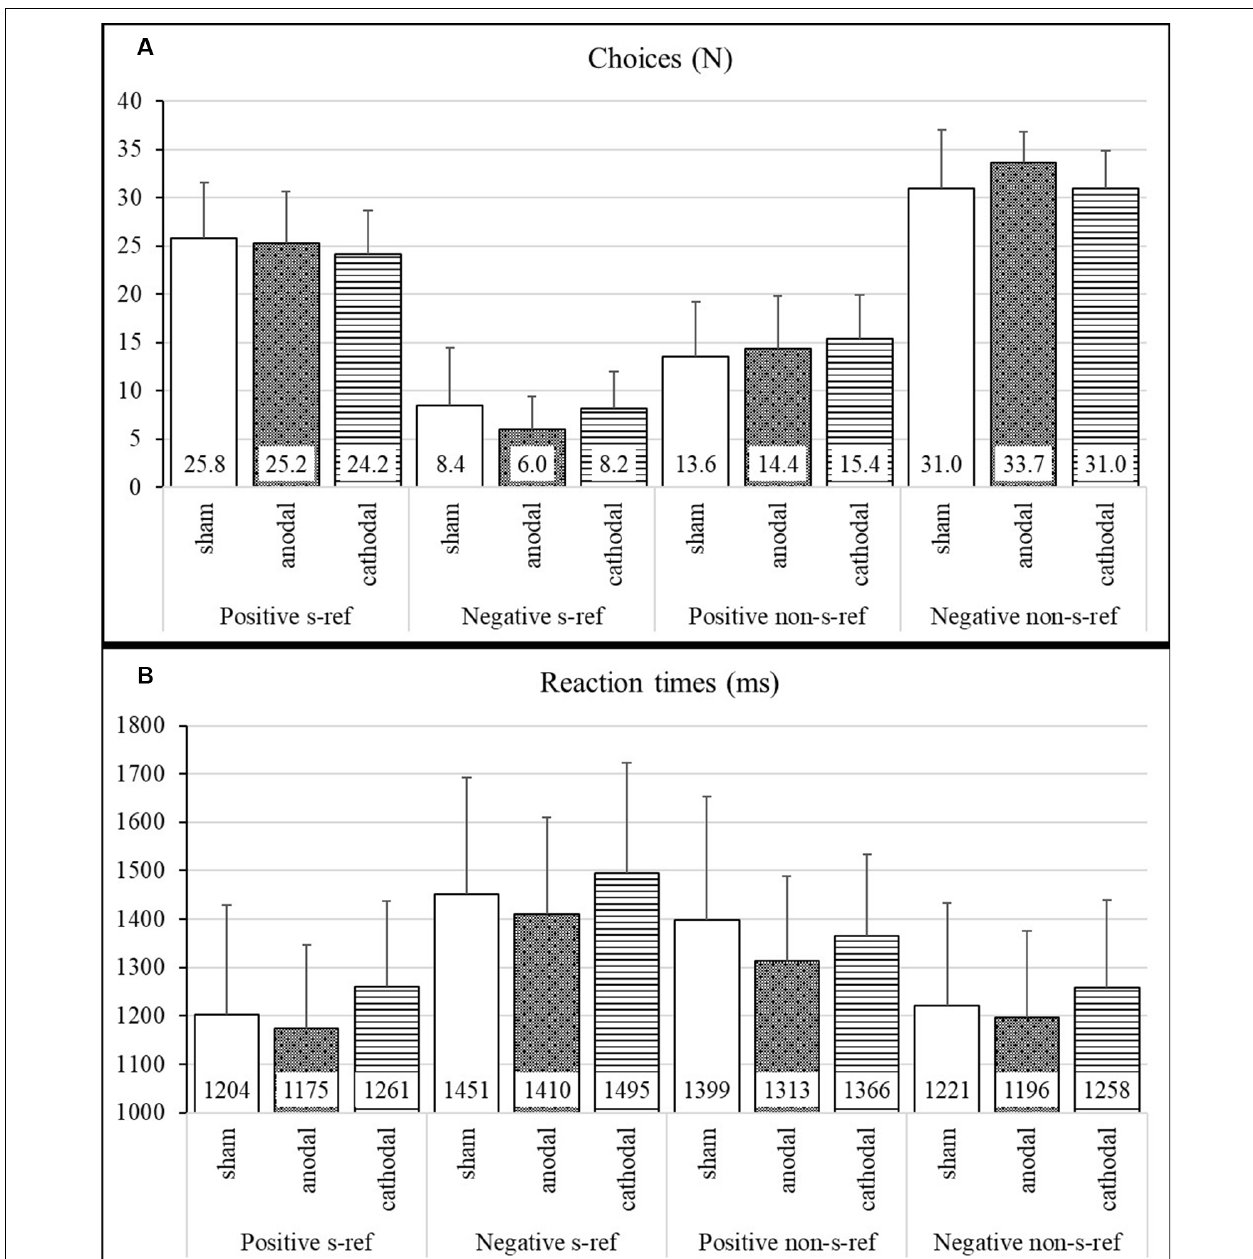
FIGURE 1 | Self-serving bias—number of chosen adjectives and reaction times (RTs) in the stimulation groups. (A) Group means and standard deviations for the number of choices ( N ). (B) Group means and standard deviations for RTs in milliseconds (ms).